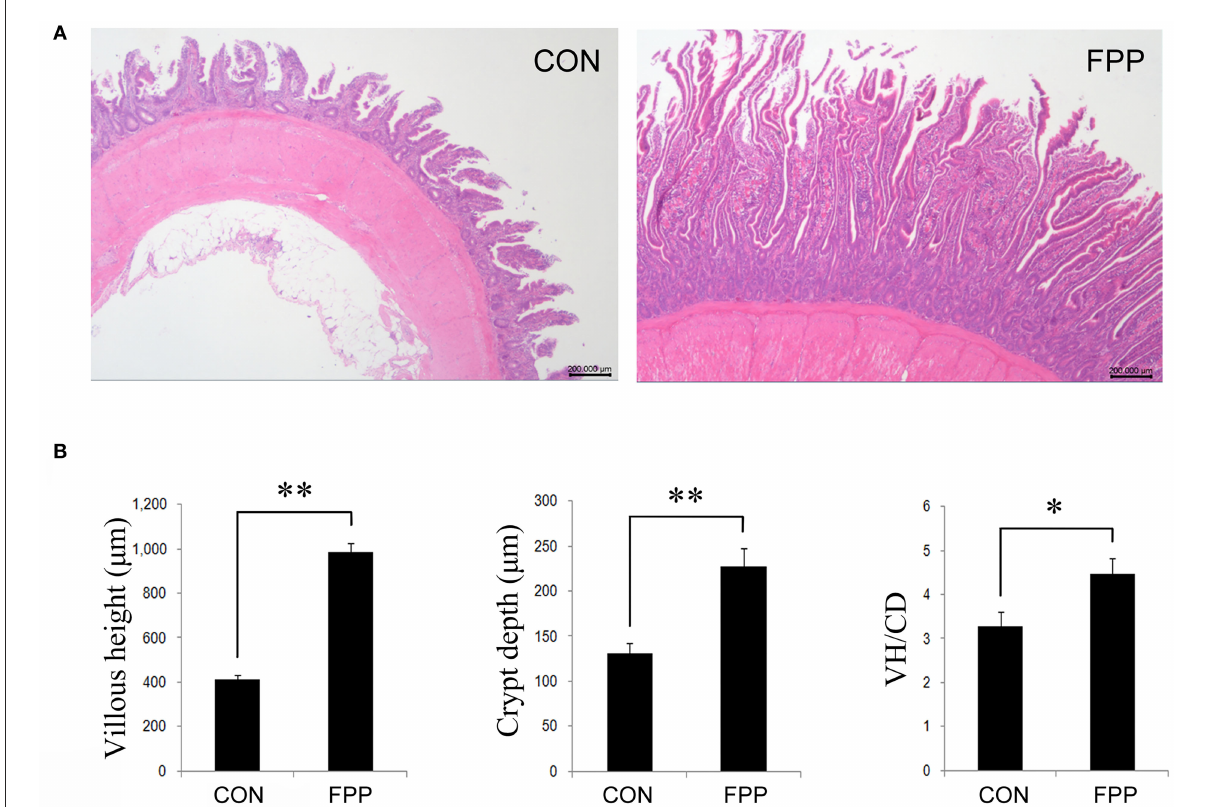
FIGURE1 Effect of the fermented plant product (FPP) on jejunal histology and histomorphometry of laying hens. (A) Histomorphology of jejunal of laying hens from the CON and FPP treatments. Hematoxylin and erosion (H&E) staining. Scale bar, 200 µ m. CON, basal diet without additive; FPP, basal diet + 500 mg/kg of FPP. (B) Villus height (VH), crypt depth (CD), and VH/CD ratio in the jejunum of laying hens-fed basal diet with 0 and 500 mg/kg FPP. * P < 0.05, ** P <